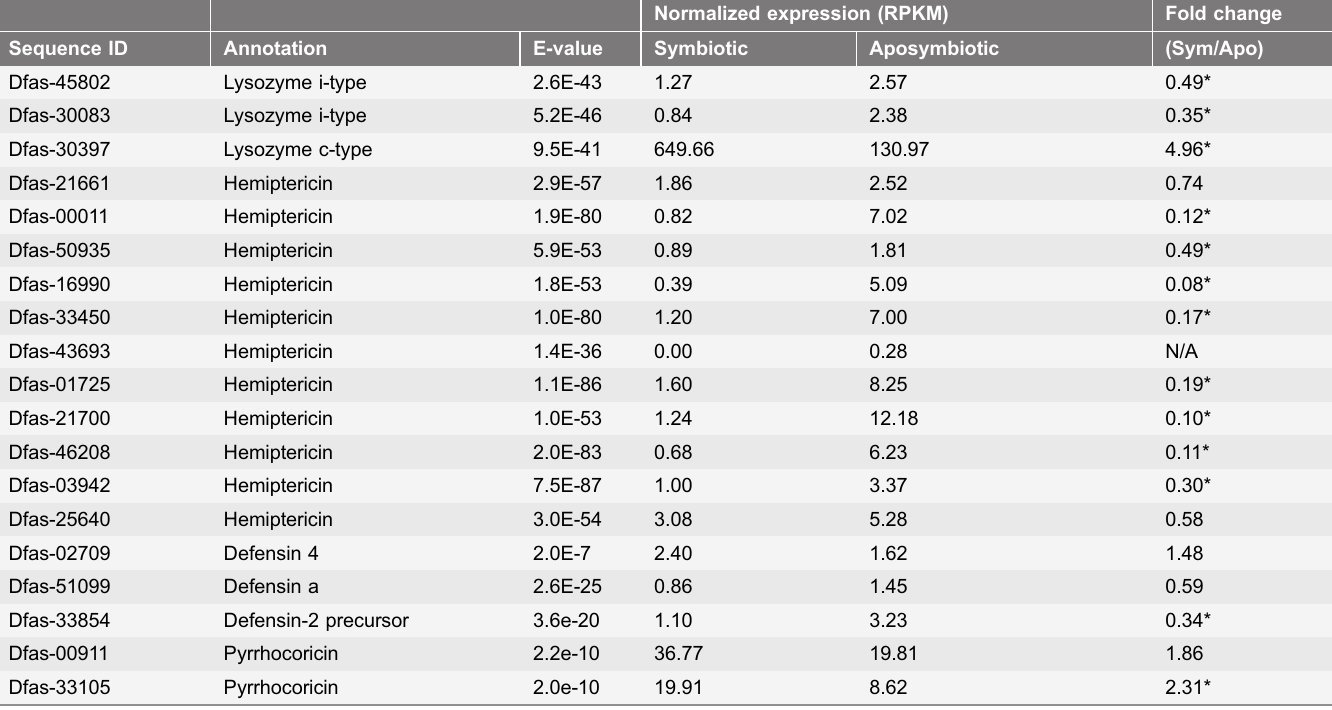
Normalized expression (RPKM) Fold change